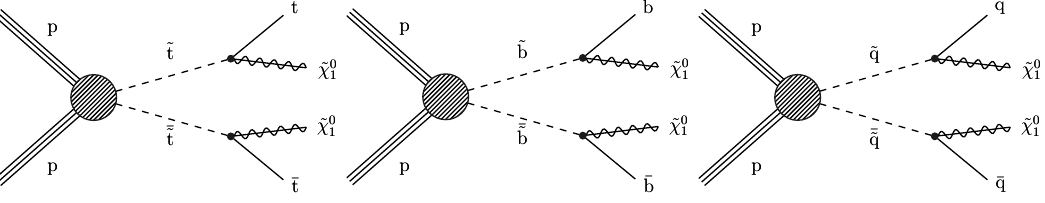
Figure 2 . Diagrams for the simpli(cid:12)ed models with direct squark pair production considered in this study: (left) T2tt, (middle) T2bb, and (right)